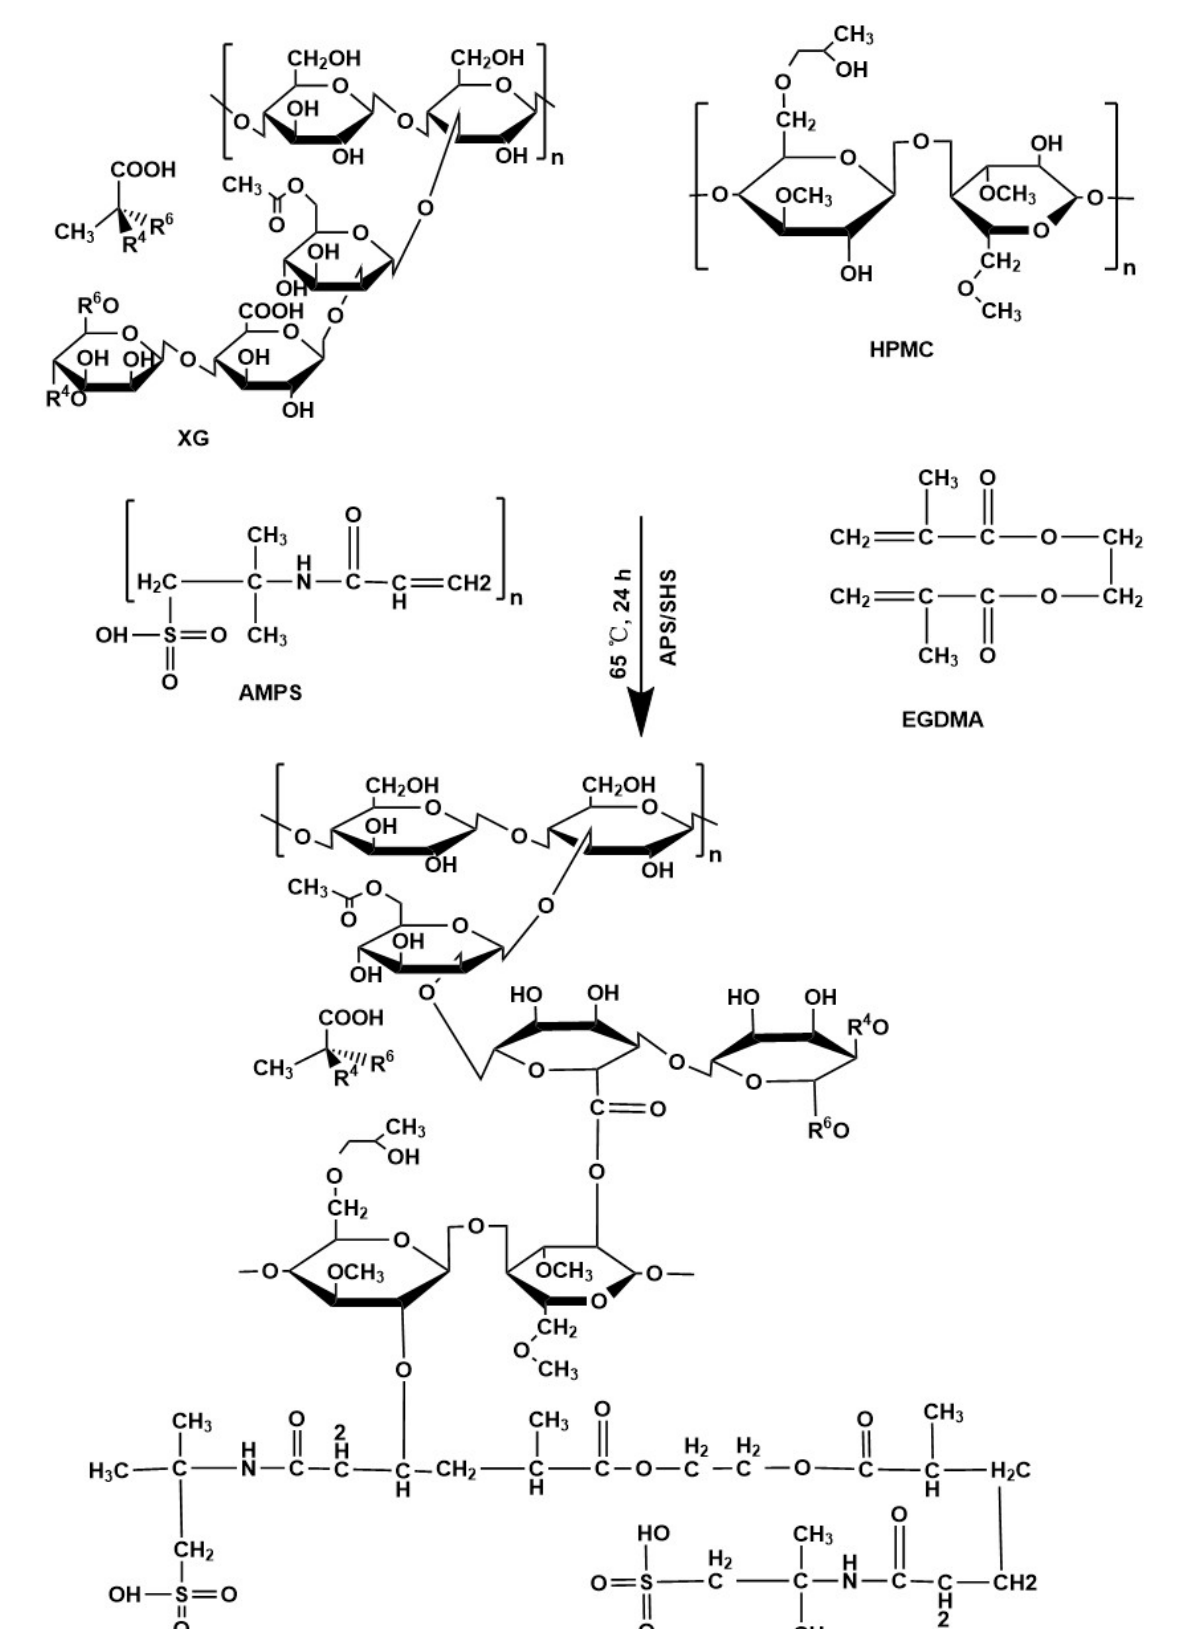
Figure 1. Proposed chemical structure of the xanthan gum-based (HPMC- g -AMPS) hydrogels.